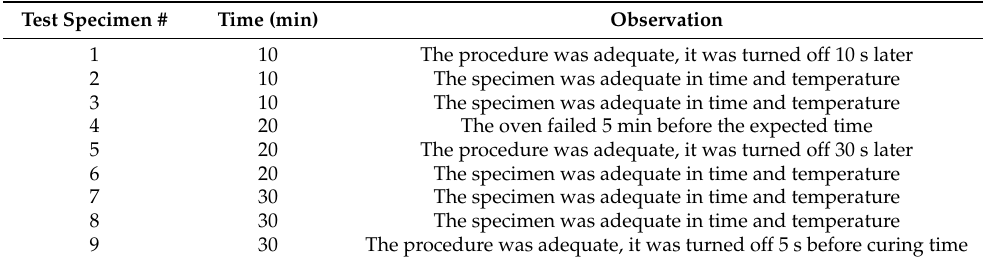
Table 1. Result of the curing processes of the test specimens for embedding and microscopic observation.